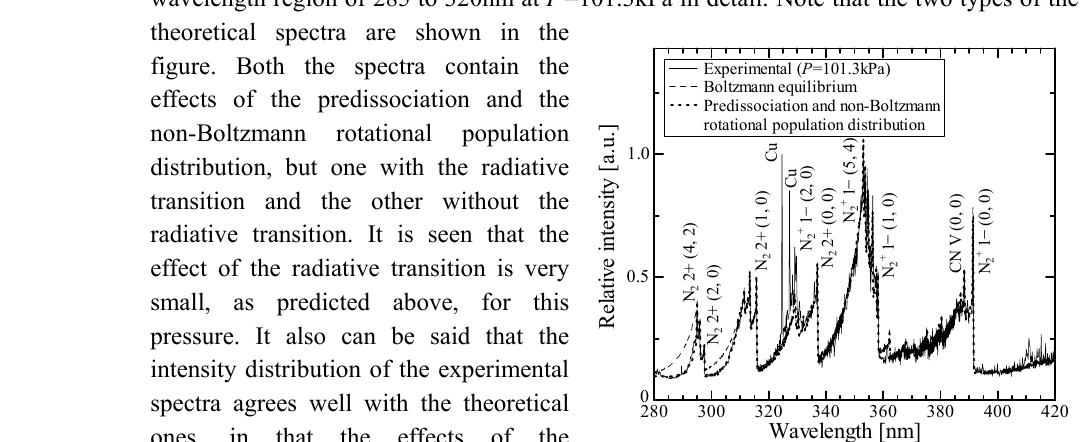
Fig. 8 Comparison of experimental and theoretical spectra at an atmospheric